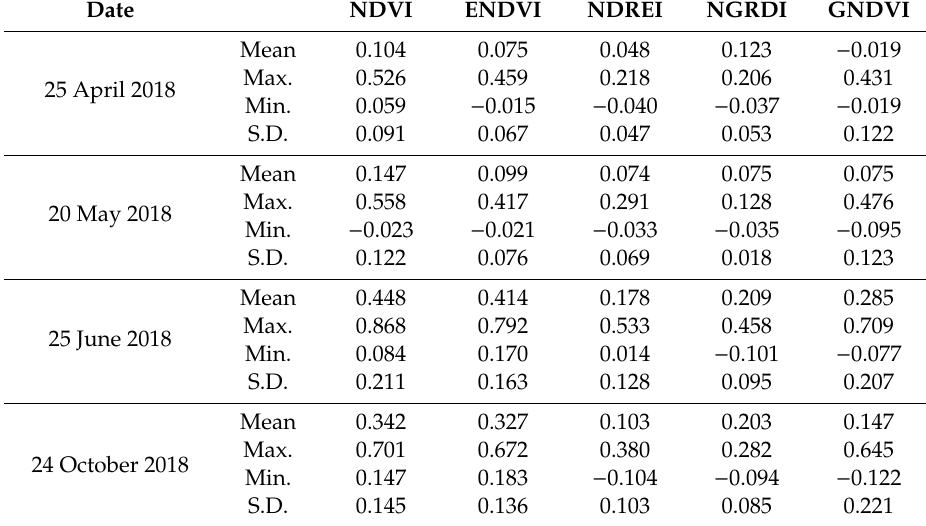
Table 5. Profile analysis result: mean value, maximum and minimum values, and standard deviation (S.D.) of each vegetation